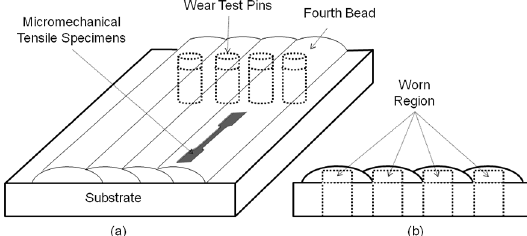
Figure 2. Schematic positioning of microtensile specimens and wear pins (a) and detail showing the top of the pins with the hardface coatings (b).